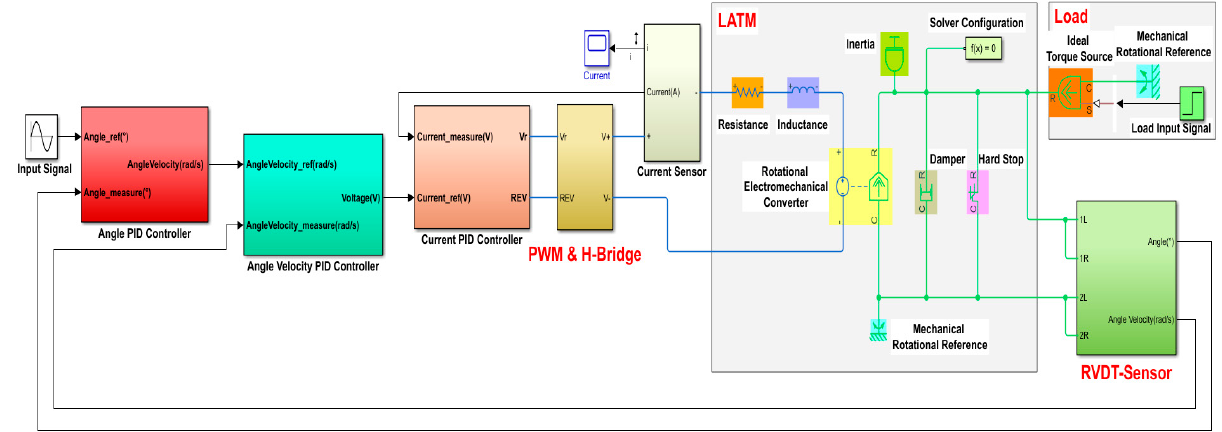
Figure 10. Simulation model of limited-angle torque motor control system based on Simscape.